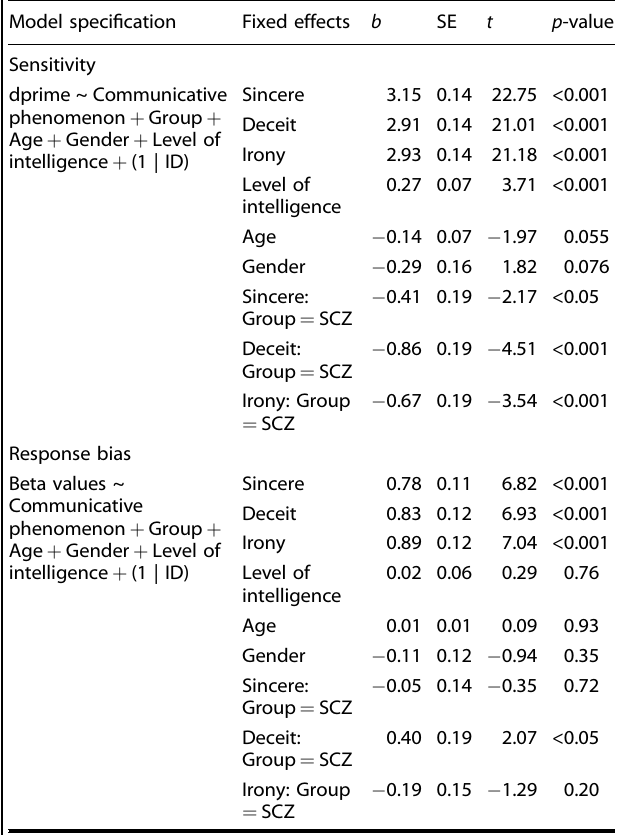
Table 4. Regression models comparing patients with SCZ and HC.